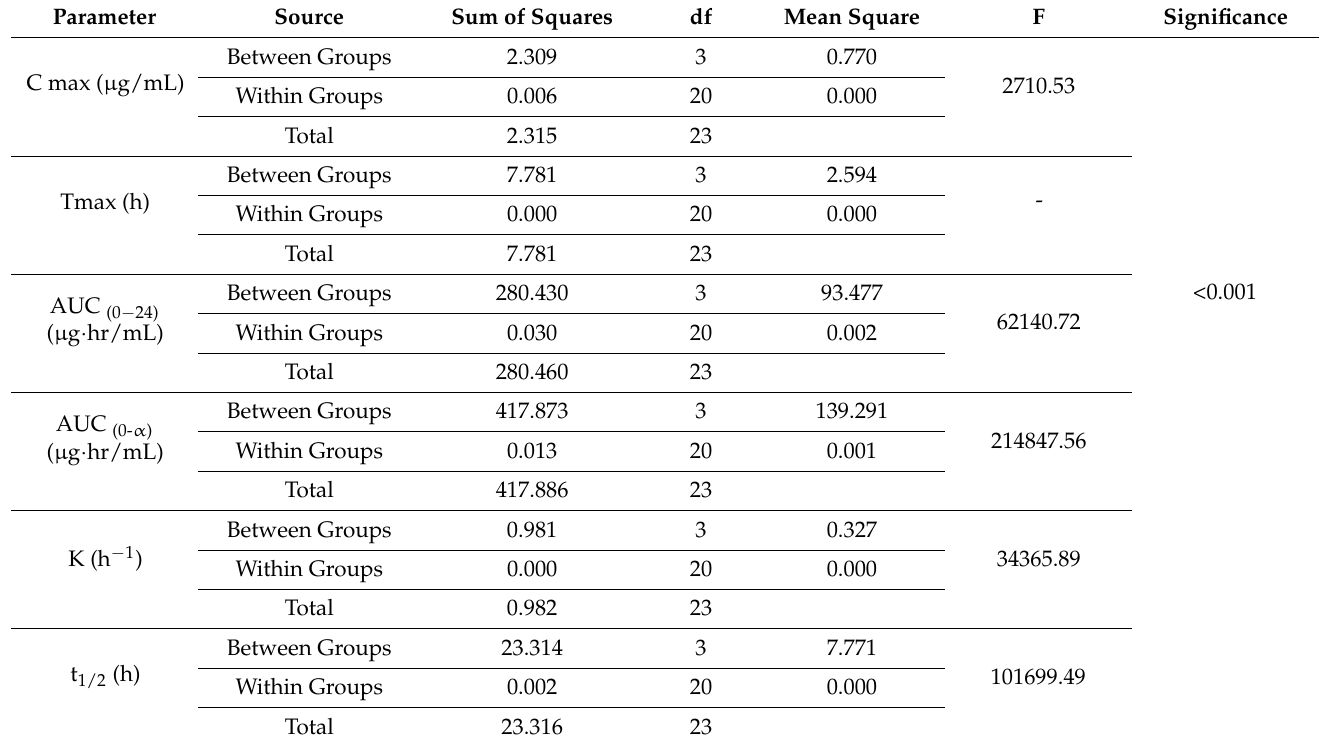
Table 9. One way ANOVA test for NIC pharmacokinetic brain data following IN and IV administration from NLC formulation and solution in